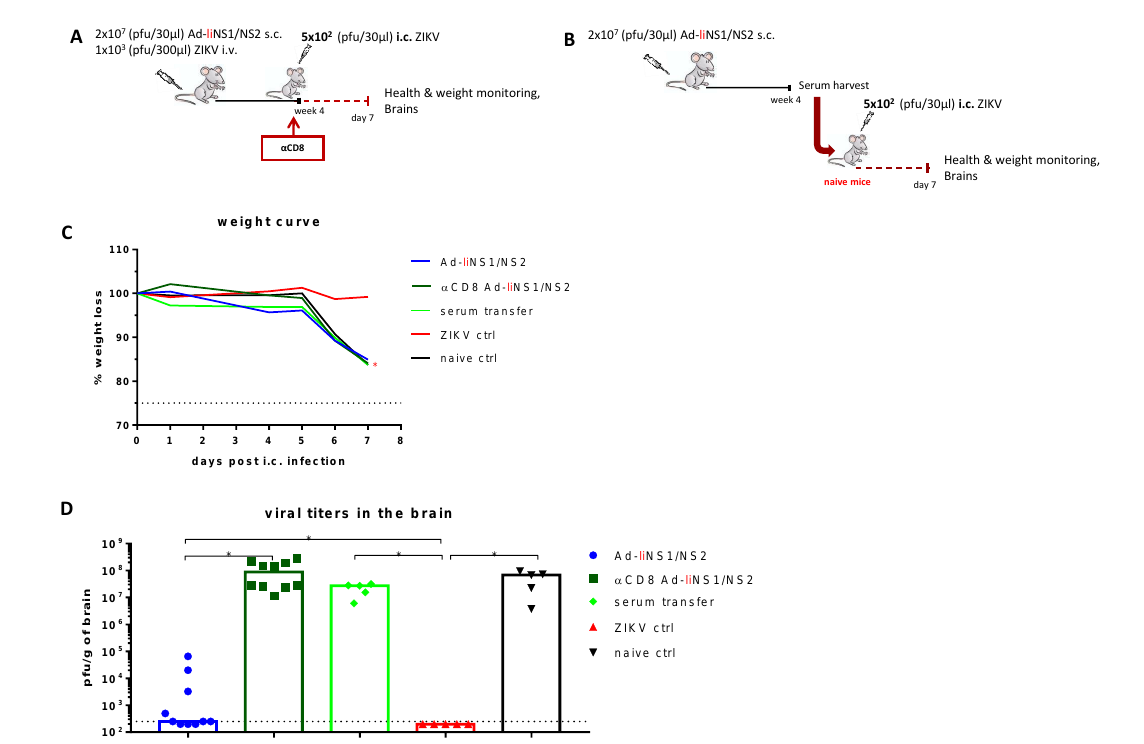
Figure 5. Contribution of CD8 T cells and anti-NS1 antibodies in Ad-liNS1/NS2 mediated protection. ( A ) Graphical representation of the experimental setup used to study the effect of CD8 T cells in protection. WT C57BL/6 mice were vaccinated s.c. with 2 × 10 7 pfu of Ad-liNS1/NS2 and four weeks later, mice were depleted of CD8 T cells ( α CD8-Ad- liNS1/NS2) prior to i.c. challenge with 5 × 10 2 pfu ZIKV. A group of vaccinated, undepleted mice along with ZIKV-immune and naive mice were included for comparison. ( B ) Graphical representation of the experimental setup used to study the effect of anti-NS1 antibodies in protection. WT C57BL/6 mice were vaccinated s.c. with 2 × 10 7 pfu of Ad-liNS1/NS2 and four weeks later, serum was harvested and transfused to naive recipient mice three and one day prior to i.c. challenge with 1 × 10 3 pfu ZIKV. ( C ) All groups were weighed and monitored daily following i.c. challenge. ( D ) On day 7 post i.c. challenge, brains were removed, and viral titers were determined by a standard plaque assay. The detection limit for virus in brain was 250 pfu/g organ and is displayed as a stippled line. Each dot represents an individual animal. The columns represent the group medians and results for the α CD8 depletion set-up were pooled from two independent experiments. * p < 0.05. For the weight curves, error bars were omitted for clarity, instead, stars denote a statistical significant difference compared to the unvaccinated control